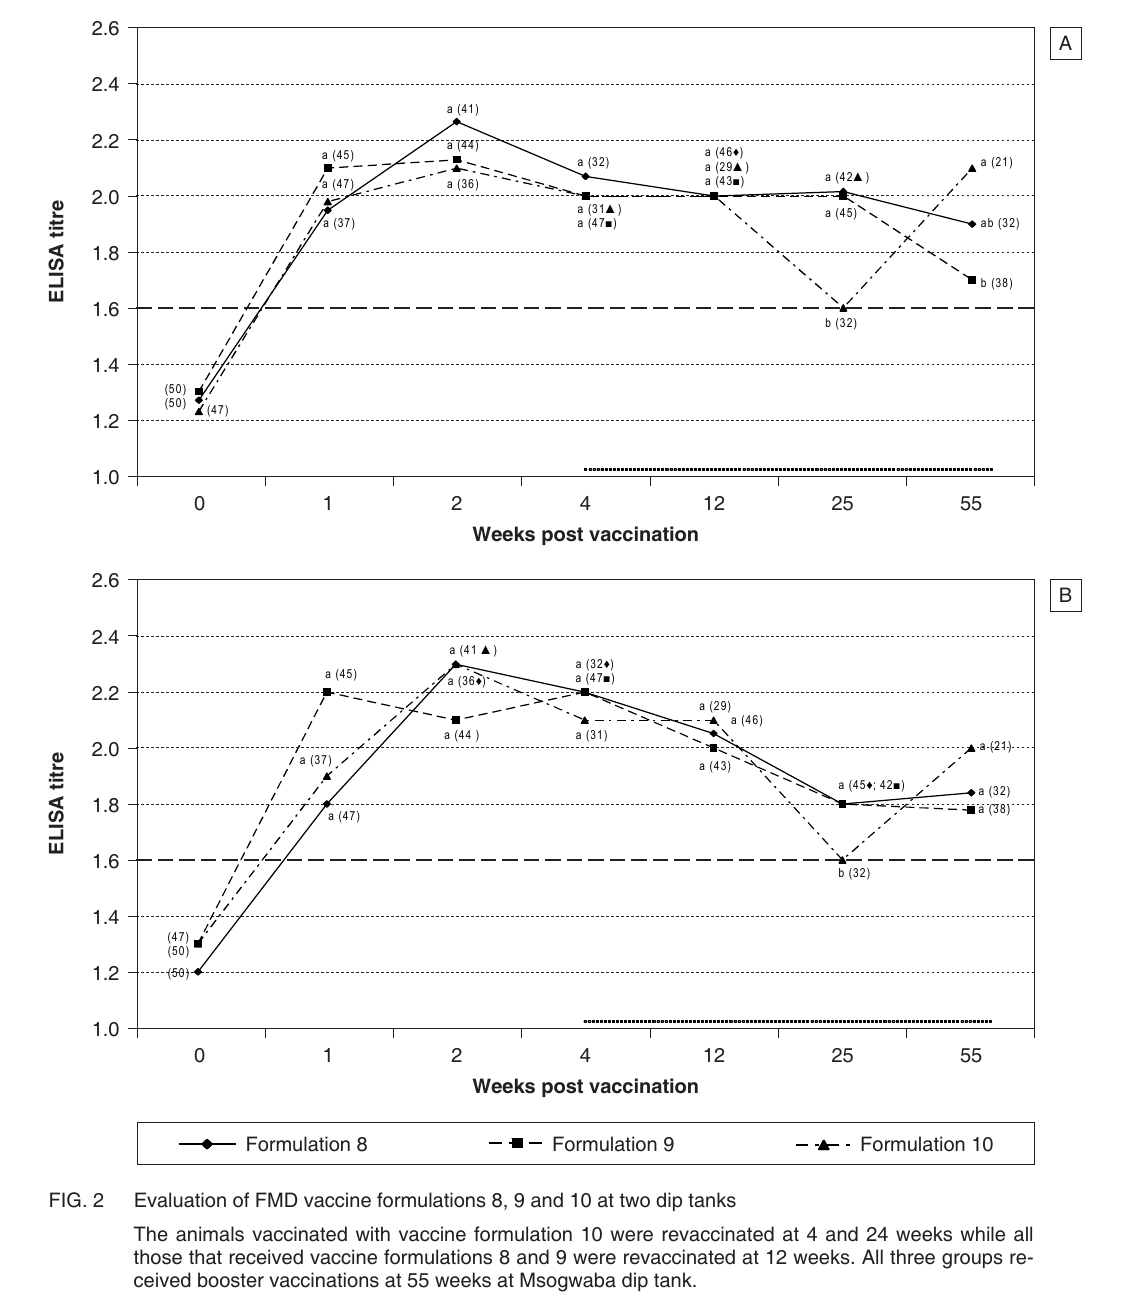
FIG. 2 Evaluation of FMD vaccine formulations 8, 9 and 10 at two dip tanks The animals vaccinated with vaccine formulation 10 were revaccinated at 4 and 24 weeks while all those that received vaccine formulations 8 and 9 were revaccinated at 12 weeks. All three groups re- ceived booster vaccinations at 55 weeks at Msogwaba dip tank. The graphs represent the average titres against the different vaccine formulations as determined using a LPB-ELISA, and ≥ 1.6log was taken as positive. The data were analyzed using an unbalanced de- 10 sign as described in the legend of Fig 1. Average titres to SAT 1 (A), SAT 2 (B), and SAT 3 (C) FMD vaccines strains at Daantjie and SAT 1 (D), SAT 2 (E) and SAT 3 (F) at Msogwaba dip tanks are indi- cated in separate graphs. The numbers of sera collected and analysed at each time point are indicated in brackets. If the probability for difference was < 0.01, the statistically significant differences between the groups vaccinated with different vaccine formulations at each time point are denoted by different letters, and when the probability was > 0.01, there were no differences in immune response and are denoted by the same letter. The dotted line at the bottom of the graphs from week 4 represents extended intervals be- tween sampling